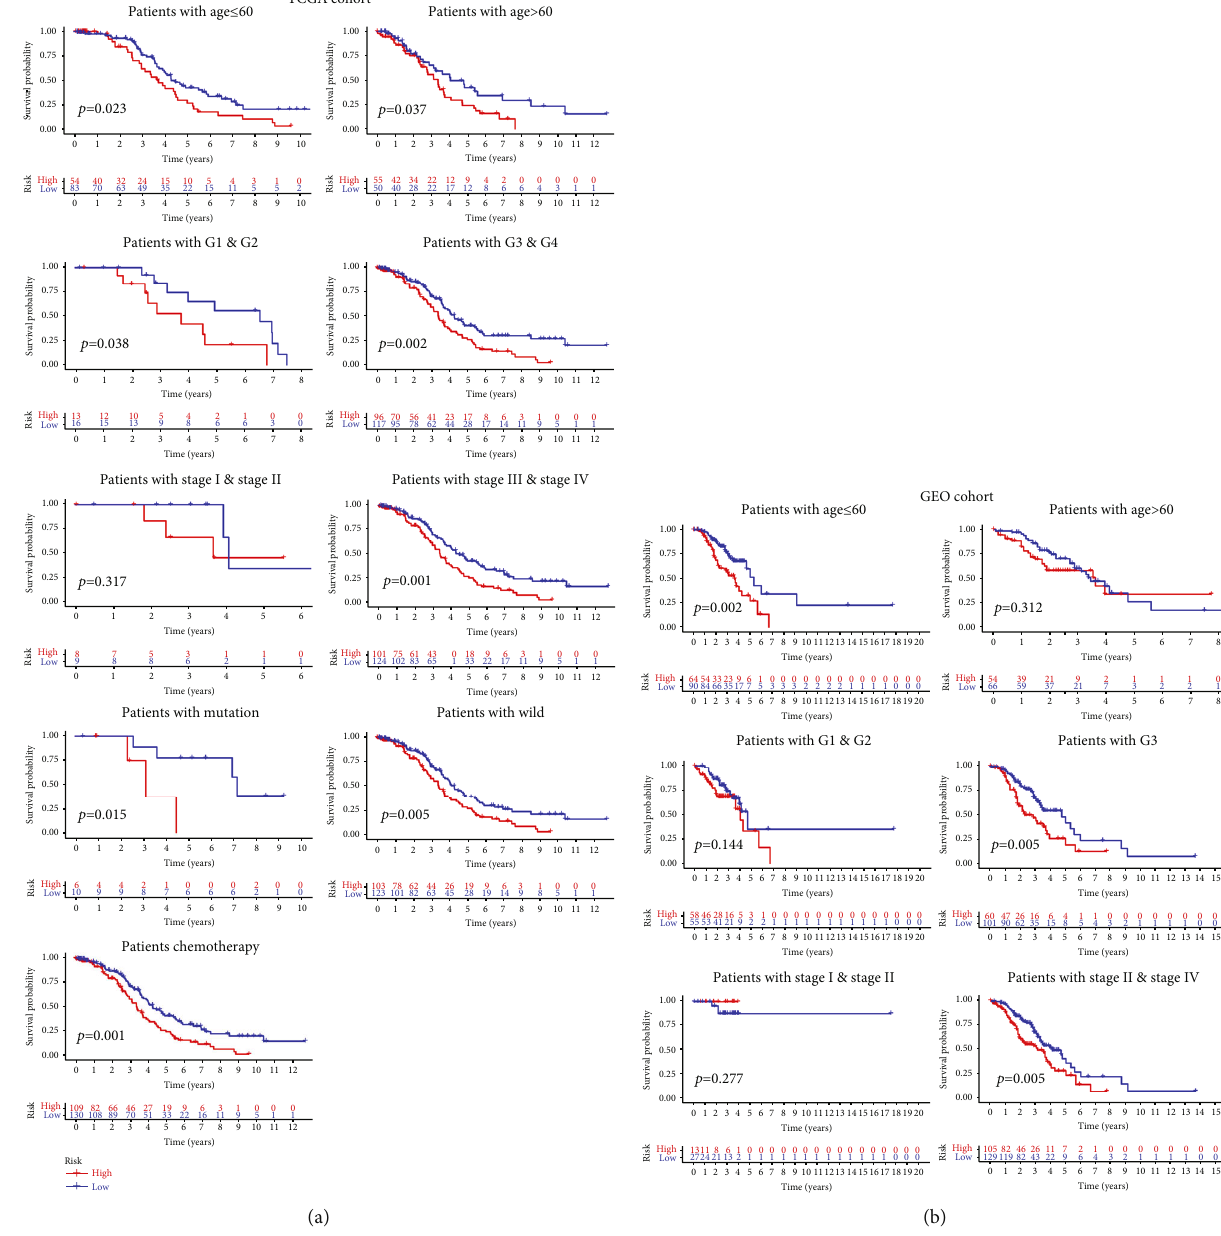
Figure 3: The ability of ERGRS to distinguish survival probability under di ff erent clinical characteristics. (a) In the TCGA cohort, Kaplan- Meier curves of di ff erent risk groups with di ff erent clinical characteristics, including age, tumor stage, tumor grade, BRCA1 type, and treatment type. (b) Kaplan-Meier curves of di ff erent risk groups with di ff erent characteristics of age, tumor stage, and tumor grade in the GEO